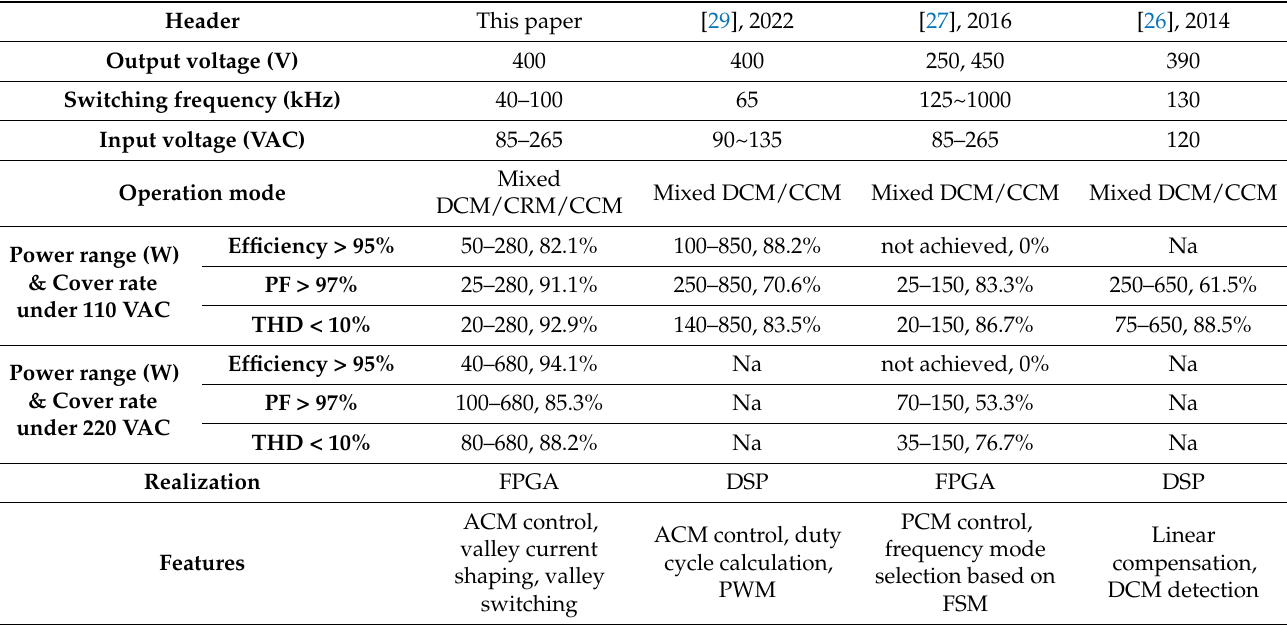
Table 3. Comparisons with other